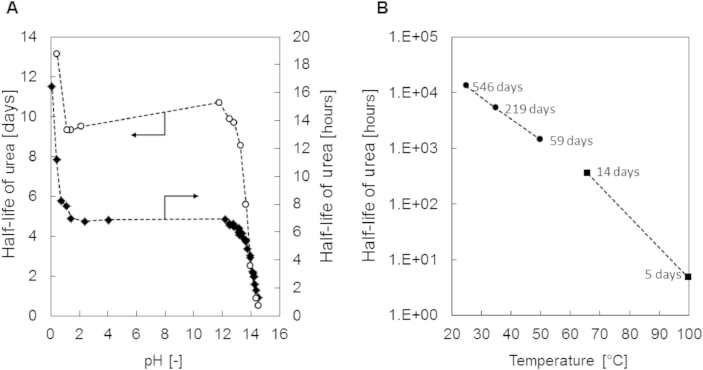
(A) Half-life of urea for different pH levels based on the non-enzymatic hydrolysis postulated by Warner (1942) at 66 °C (o) in days and 100 °C (◆) in hours. (B) Stability of urea affected by non-enzymatic hydrolysis: The values at 66 °C and 100 °C (■) are directly derived from Warner (1942), while the data at 25 °C, 35 °C and 50 °C (●) are derived from (Chin and Kroontje, 1963).